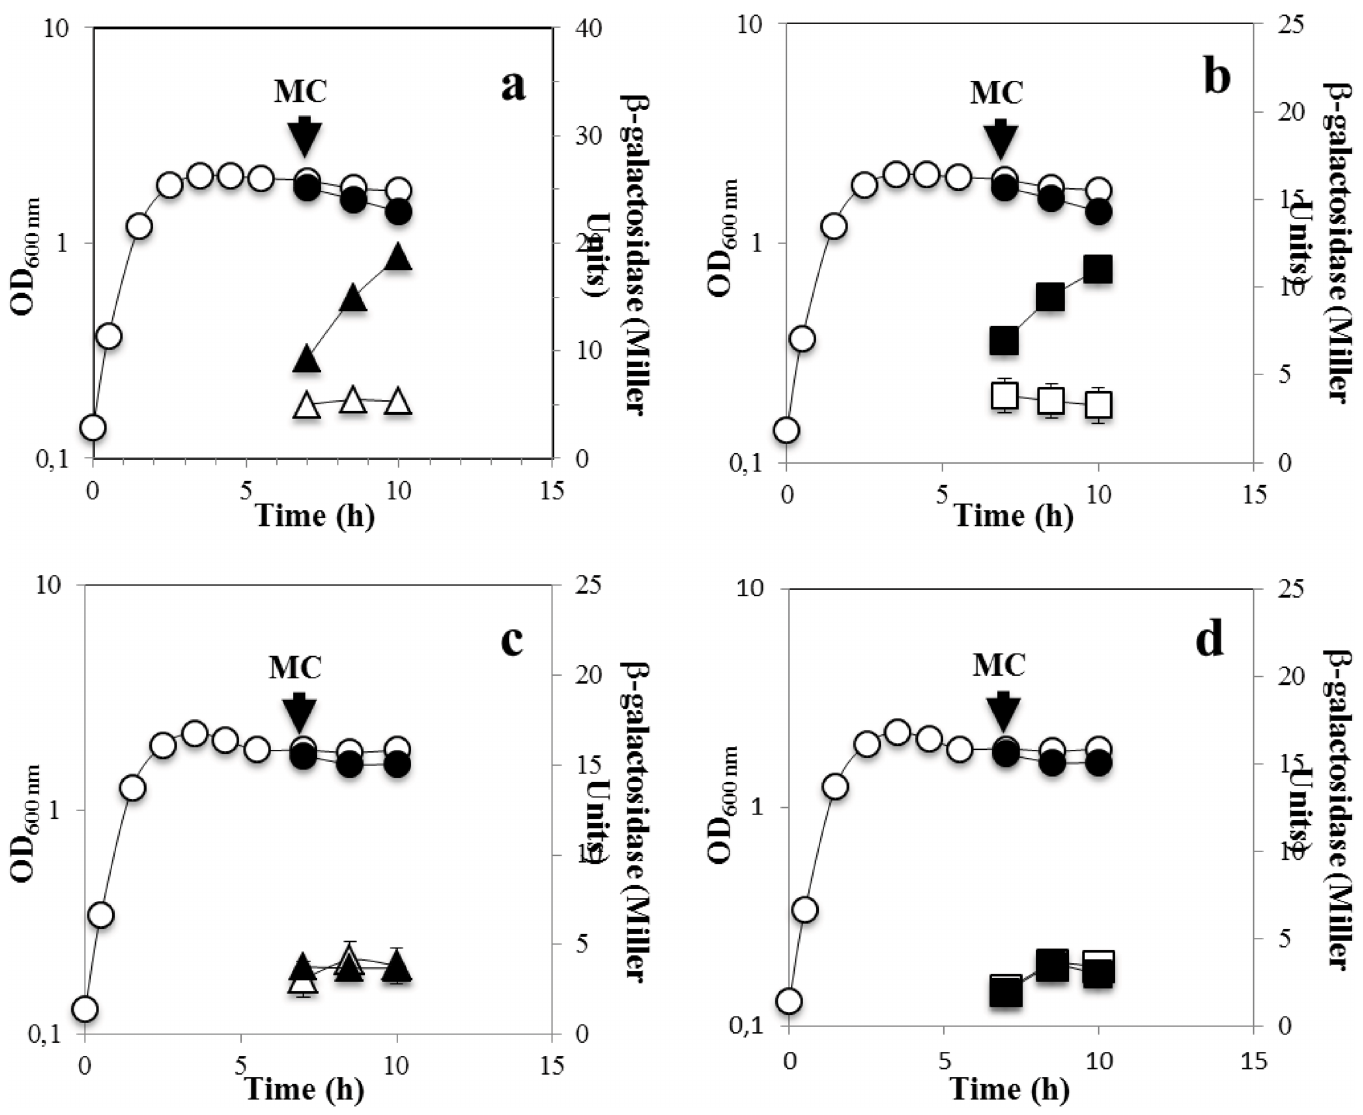
Fig 3. Levels of ß-galactosidase from recA-lacZ with and without DNA damage during sporulation in SOS-proficient (a and b) and – deficient (c and d) B . subtilis strains. B . subtilis strains LAS600 (parental) and LAS523 (SOS-deficient) containing a recA-lacZ fusion were grown and induced to sporulate in DSM. The optical densities of cultures were measured without ( (cid:3) ) or after ( ● ) DNA damaging treatment. 4 h after the onset of sporulation (T 0 ), the culture was divided into two subcultures; one subculture was challenged with M-C (500 ng/mL) and the other one was untreated. Cells samples from untreated (open symbols) or treated (filled symbols) were collected at the indicated times and ß-galactosidase specific activity in the mother cell (a and c, triangles) and forespore (b and d, squares) fractions was determined, all as described in Materials and Methods.